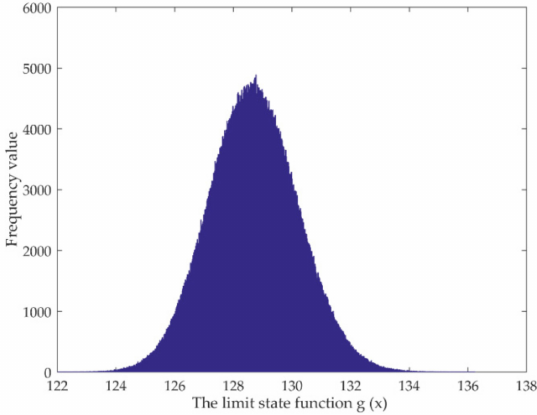
Figure 6. Frequency distribution histogram of g ( x